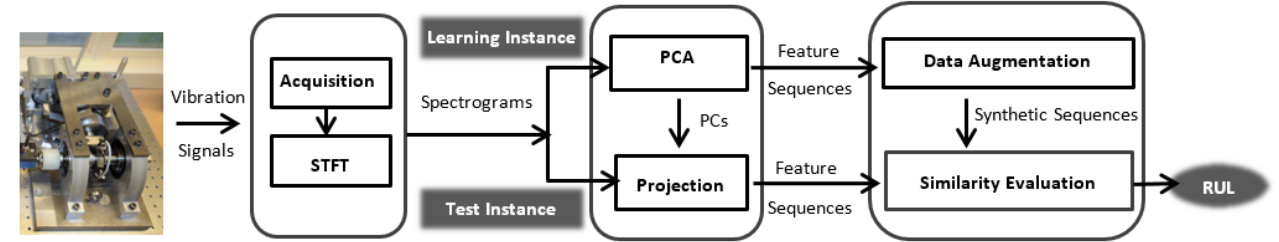
Figure 2. The proposed IBL approach for RUL estimation.